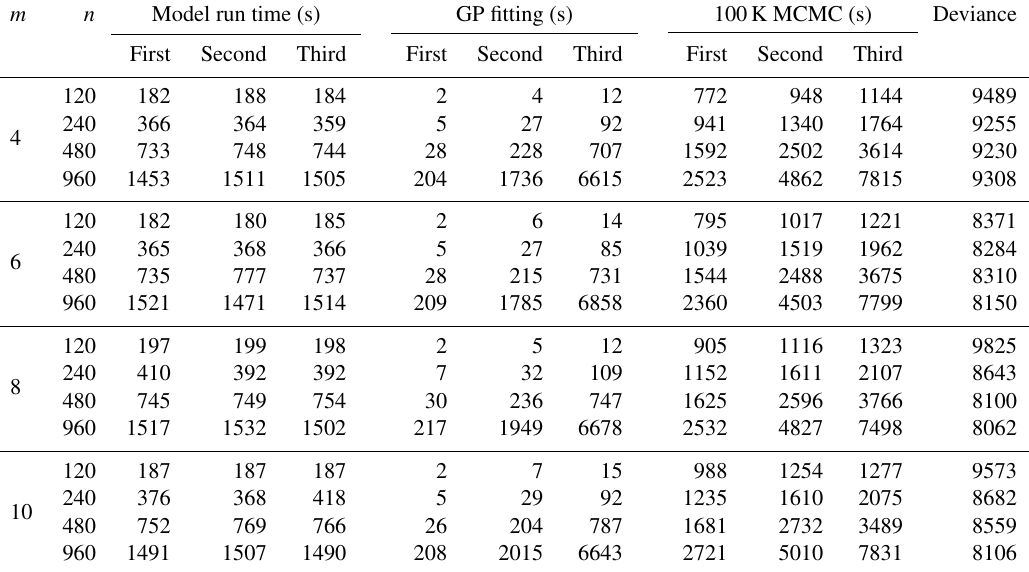
Table A9. Scaling experiment results showing the trade-off between wall-clock time and the approximation error with increasing emulator